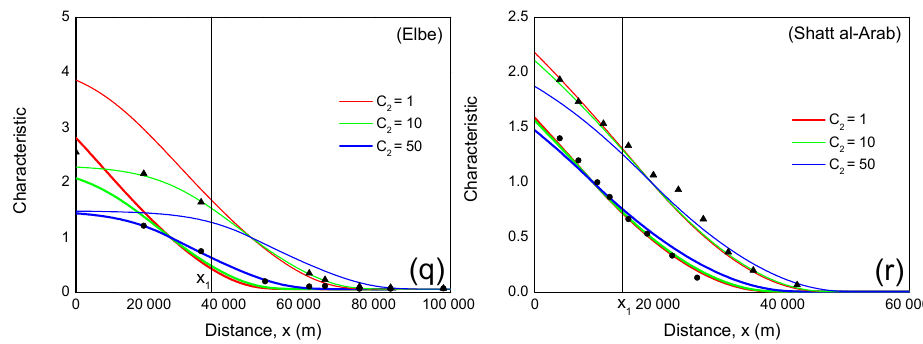
Figure C1. The same as Fig.